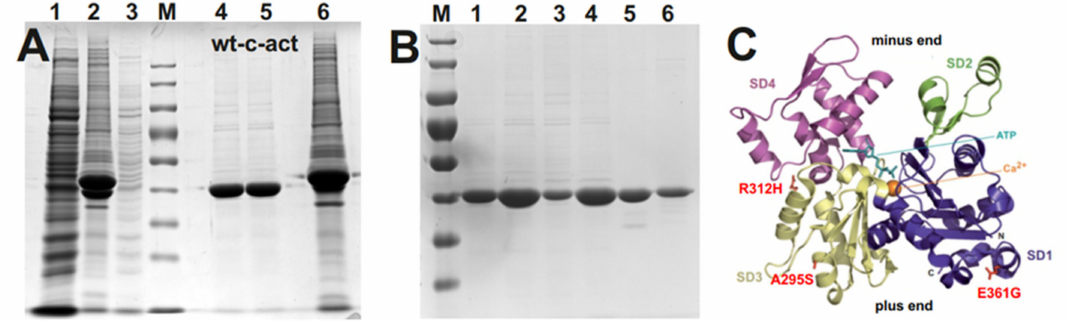
Figure 1. Purification of cardiac actins after expression by the Baculovirus/Sf21 system. ( A ) SDS-PAGE (12.5%) of examples of the purification steps of cardiac actin variants as shown for wt c-actin. Lanes: (1) crude extract of Sf21 cells before addition of His-G4-6; (2) material bound to NiNTA beads; (3) supernatant of NiNTA beads washing step with calcium-containing Hepes-OH buffer, pH 7.4; (4) actin eluted after addition of Hepes buffer containing 5 mM EGTA; (5) cardiac bovine actin as comparison; (6) NiNTA beads after elution of actin showing remaining His-tagged G4-6. ( B ) SDS-PAGE of the purified cardiac actin variants used in this study. Lanes: (1) wt; (2) p.A295S; (3) p.R312H; (4) p.E361G; (5) skeletal muscle actin; (6) bovine cardiac actin. Actins shown in lanes (5) and (6) were conventionally prepared from acetone powders. ( C ) Gives the localization of the mutated residues within the actin molecule [modified from